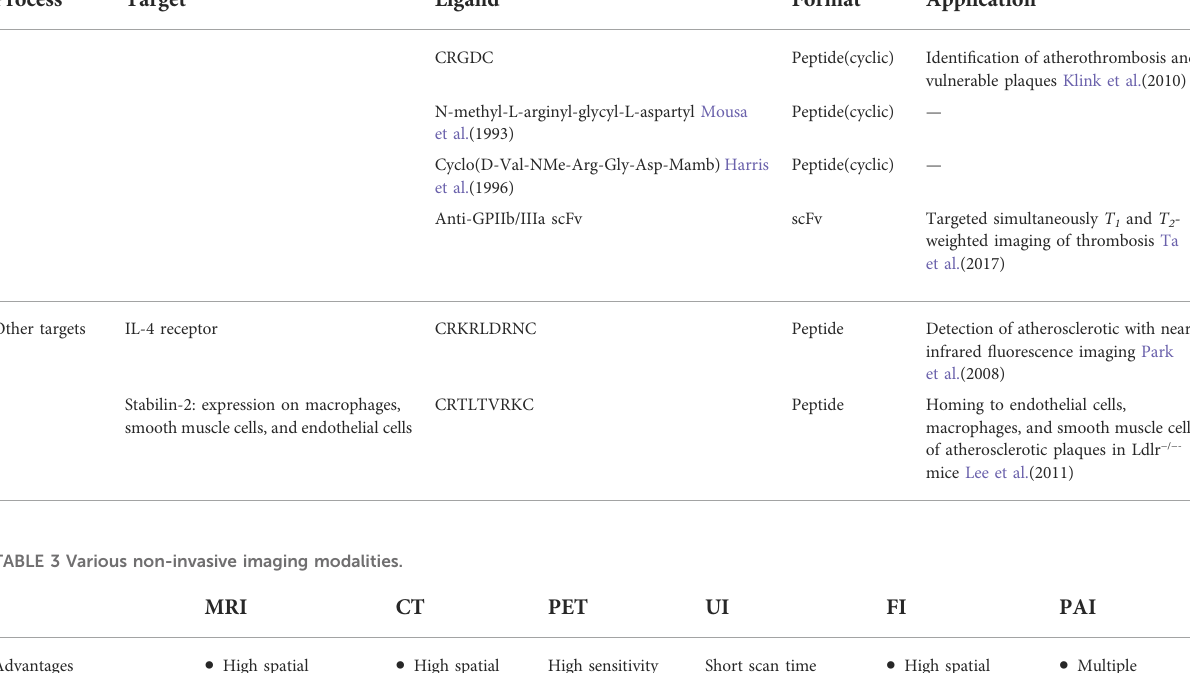
TABLE 3 Various non-invasive imaging